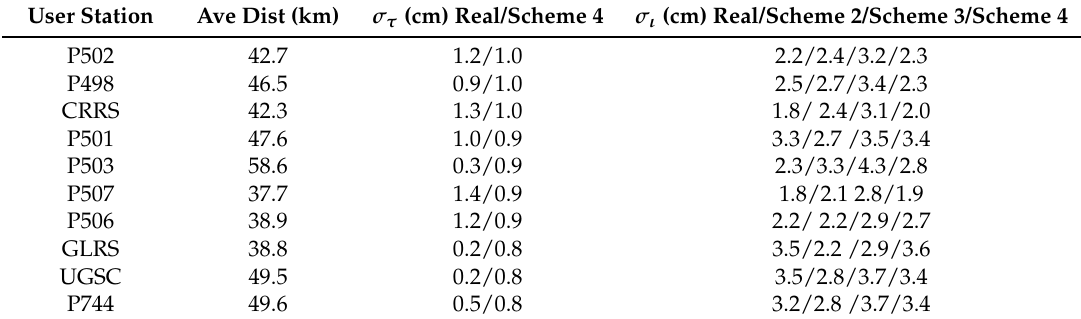
Table 1. The average accuracies of the interpolated atmospheric correction with medium inter-station distance network.